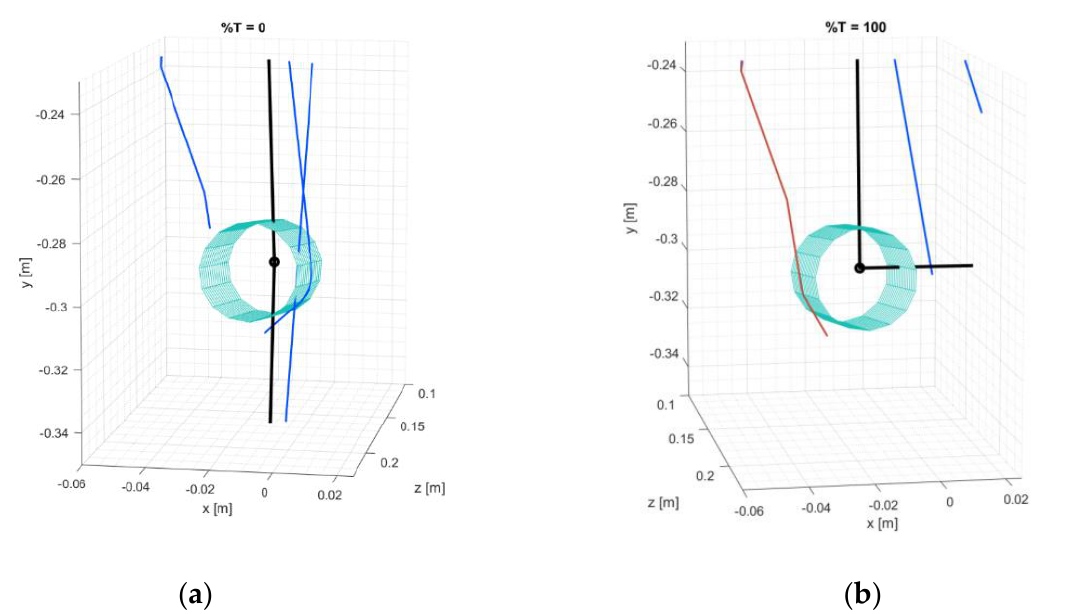
Figure 11. Elbow wrapping in the ( a ) first and ( b ) the last time instants.